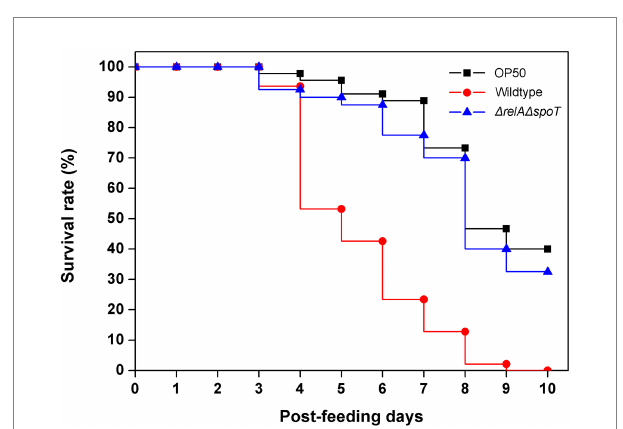
FIGURE 6 Attenuation of virulence in Δ relA Δ spoT EPEC. Virulence attenuation of the Δ relA Δ spoT mutant strain was analyzed by nematode killing assay. The wildtype (red circle) and Δ relA Δ spoT mutant (blue triangle) strains were seeded with synchronized Caenorhabditis elegans . Survival rates of C. elegans were then monitored for 10 days post- feeding. E. coli OP50 strain was used as a control (filled